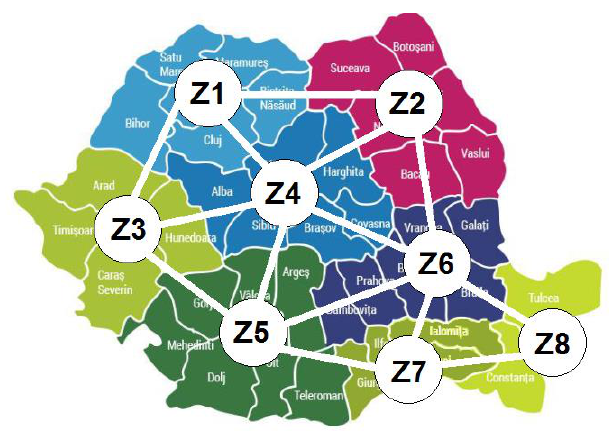
Figure 6. Construction of bidding zones in the case